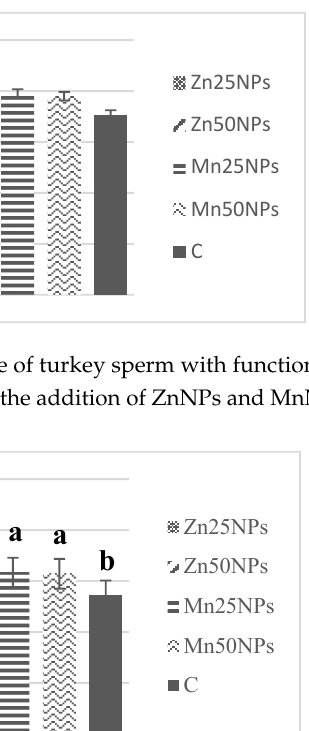
Figure 4. Percentage of turkey sperm with functional mitochondria (%) in samples stored for 2 h with or without (C) the addition of ZnNPs and MnNPs.